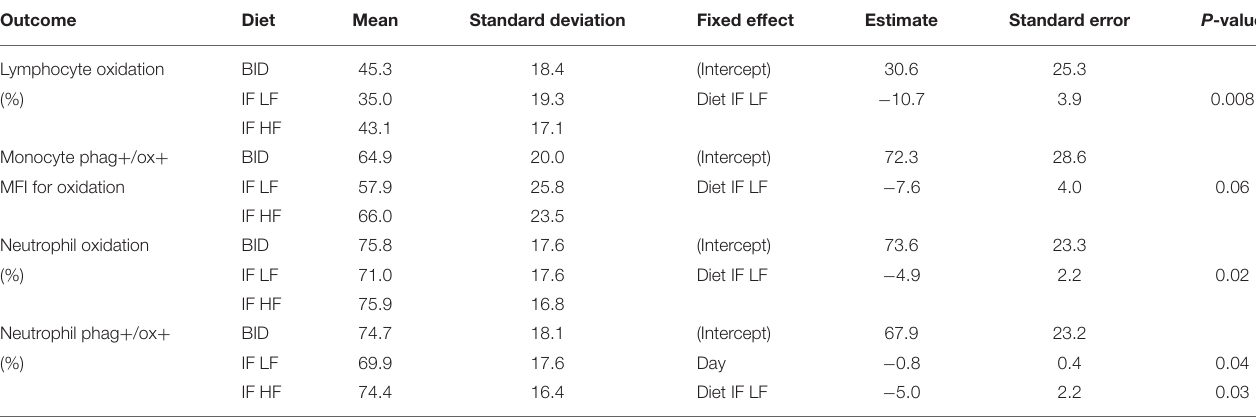
TABLE 5 | The results of the linear mixed effect models of the activity of phagocytic cells, and their respective means and standard deviations, in 10 dogs fed daily (BID), and intermittently fasted on a low fat (IF LF) and a high fat diet (LF HF) in a Latin Square design. Outcome Diet Mean Standard deviation Fixed effect Estimate Standard error P -value Lymphocyte oxidation